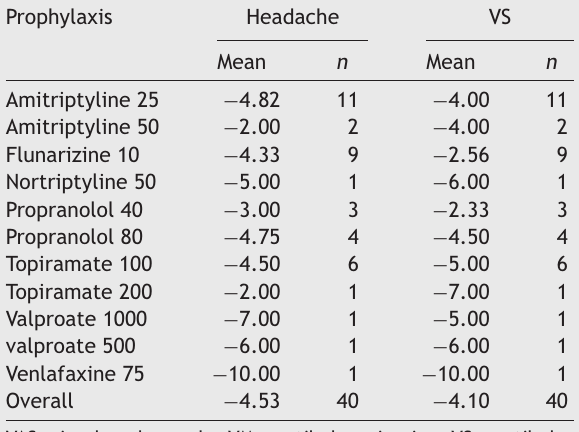
Therapeutic response assessed by the mean vari- ation of VAS after prophylactic treatment in patients with